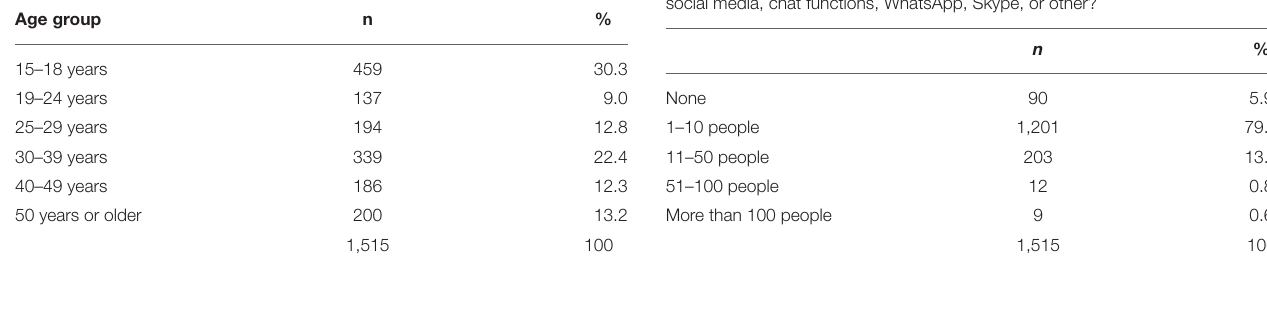
TABLE 2 | Age distribution of the subjects.